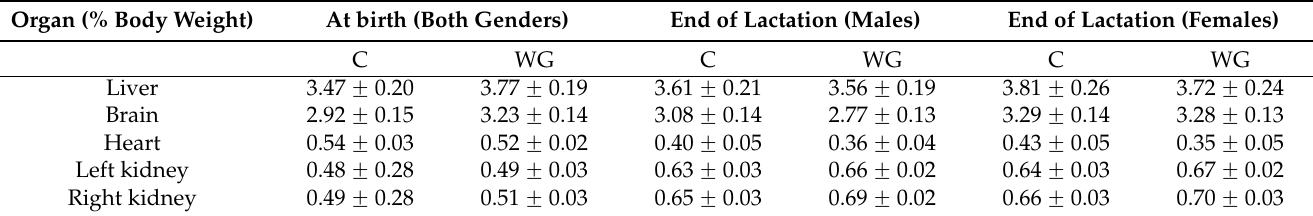
Table 2. Organ weight of offspring at birth and end of lactation.